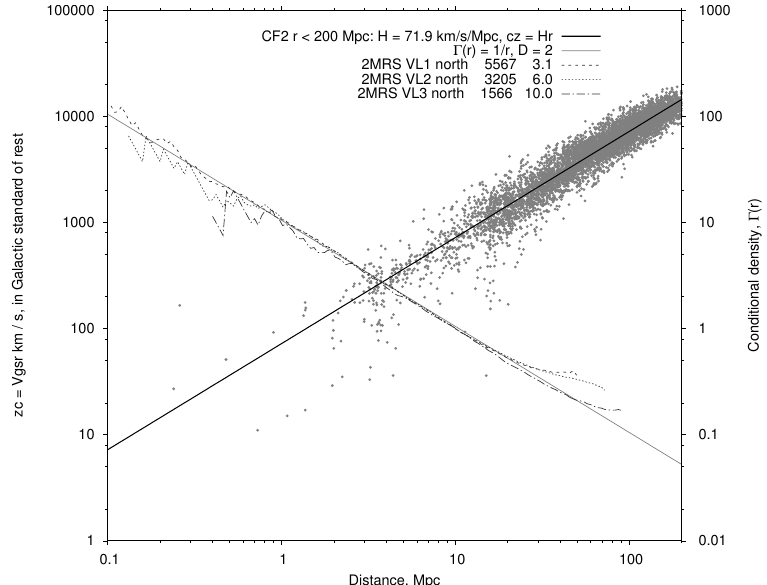
Figure 1. Presentation of the Hubble-deVaucouleurs (HdeV) paradox in the Local Universe [262]. The Hubble linear redshift law ( cz = H × R ) [298] and the fractal de Vaucouleurs density law Γ ( r ) = k r − γ with γ ≈ 1 [53], coexist at the common length-scale interval 1 ÷ 100 Mpc. While, in the frame of the SCM, the linear redshift-distance relation is the strict consequence of homogeneity